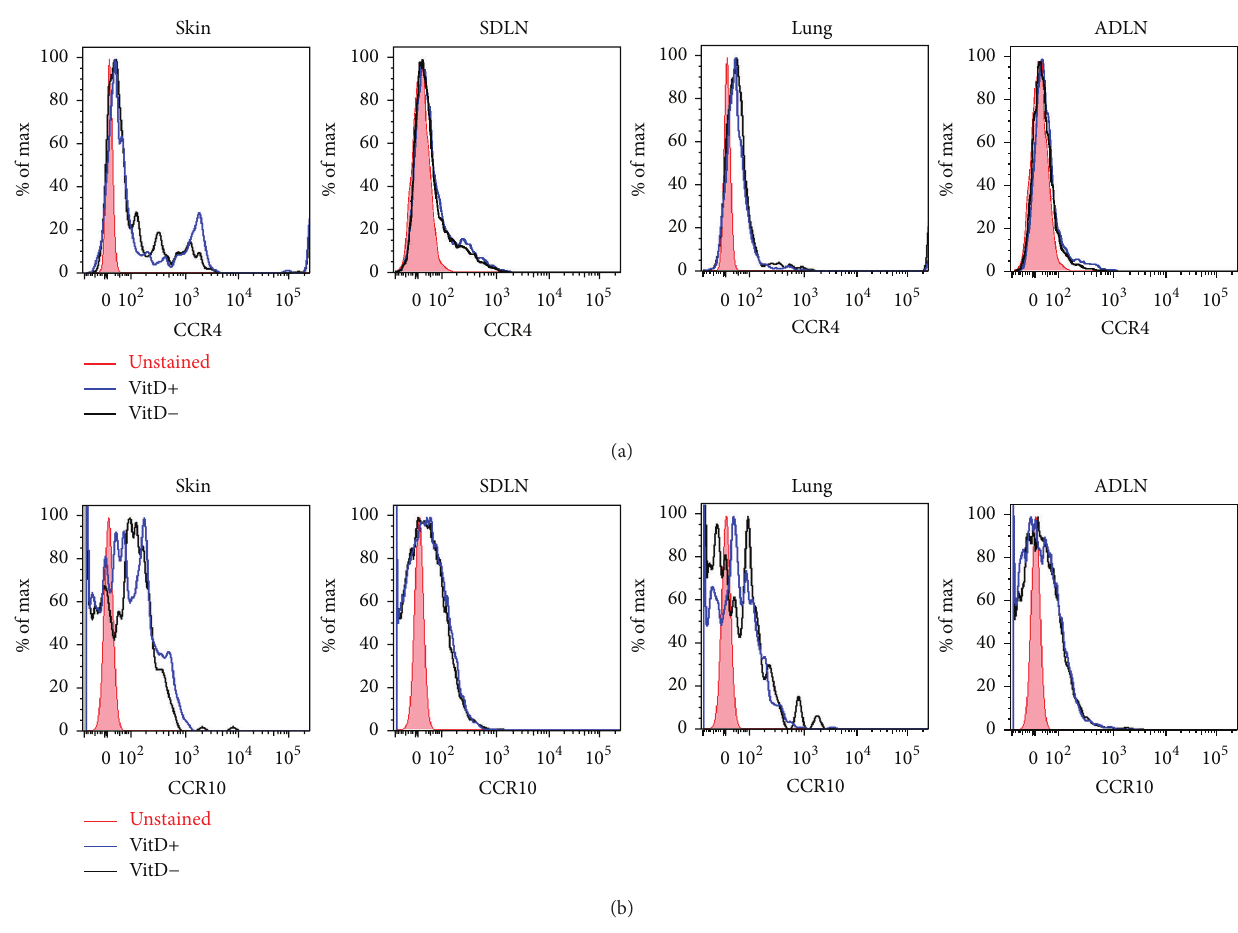
Figure 6: Dietary vitamin D 3 did not modify CCR4 or CCR10 expression on Foxp3+ T cells from the skin, SDLN, lung, or ADLN. Reg Female offspring born to vitamin D 3 -replete or vitamin D 3 -deficient BALB/c mothers were maintained on the vitamin D 3 -replete (VitD+) or vitamin D 3 -deficient diets (VitD − ) (resp.) until 8 weeks of age. The expression of (a) CCR4 and (b) CCR10 was measured on CD3+CD4+CD25+Foxp3+ cells in the skin, SDLN, lungs, and ADLN, with cells from vitamin D 3 -replete and vitamin D 3 -deficient mice shown in blue and black, respectively (unstained = red shaded). Data are representative of two